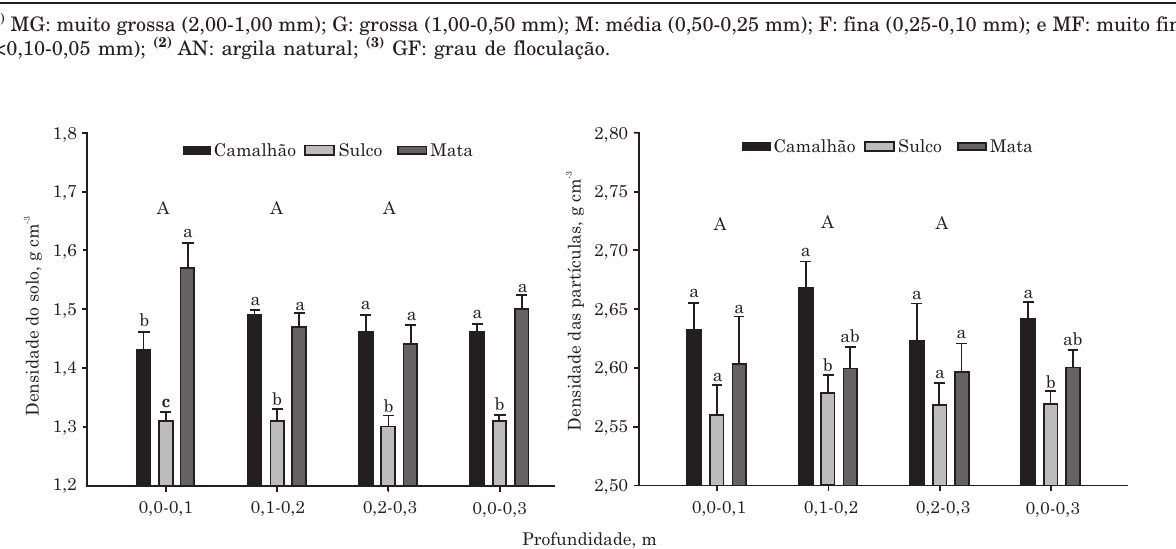
Figura 1. Densidade do solo e das partículas, com os desvios-padrão da média, para as áreas cultivadas